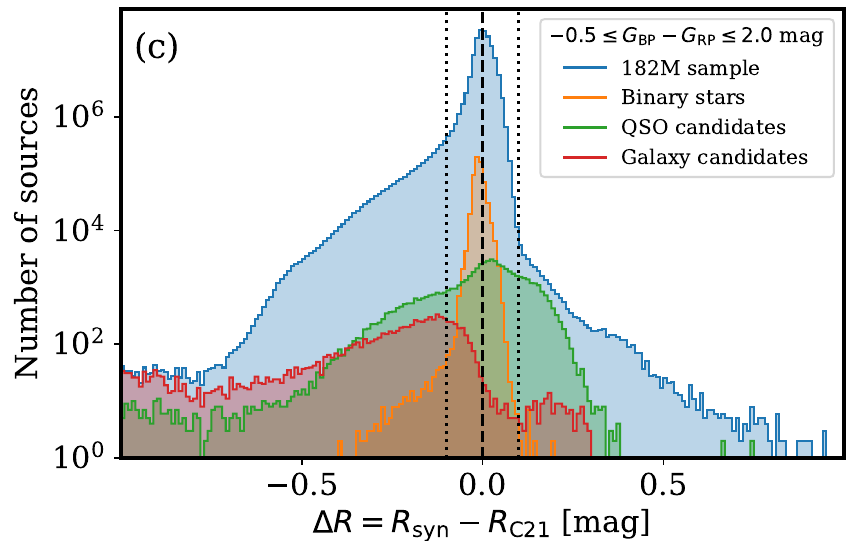
Figure 12. Histograms displaying the differences in the prediction of RGB magnitudes be- tween the values derived in this work from the Gaia XP low-resolution spectra and those es- timated using the polynomial functions published by C21. Since the latter are valid only for − 0.5 ≤ G − G ≤ 2.0 mag, we applied here the same constraint to the 200 M sample (as in- BP RP dicated in the legend title), which reduces, in this analysis, the 200 M sample to ∼ 182 million objects (182 M sample). Panels ( a – c ) show the results for the B RGB , G RGB and R RGB bands, respectively. Within each panel, we segregate the resulting histograms as shown in Figure 7. The vertical dashed line corresponds to ∆ X = X syn − X C21 = 0 mag with X= B RGB , G RGB and R RGB , whereas the vertical dotted lines are used in each panel to highlight the ± 0.1 mag interval, which encompasses 93.6%, 97.8% and 98.3% of the sources in panels ( a – c ), respectively. 2D histograms representing the same dataset as a function of relevant parameters are shown in Figure